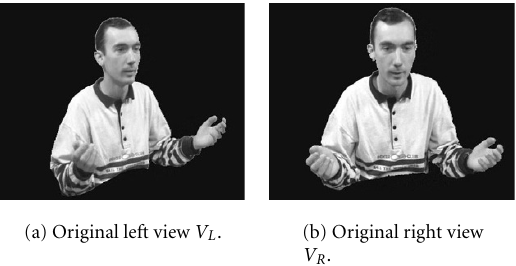
Figure 7: The stereo views are rectified considering the epipolar geometry. Thus two constraints can be applied to make them have the same smallest possible size 1012 ×